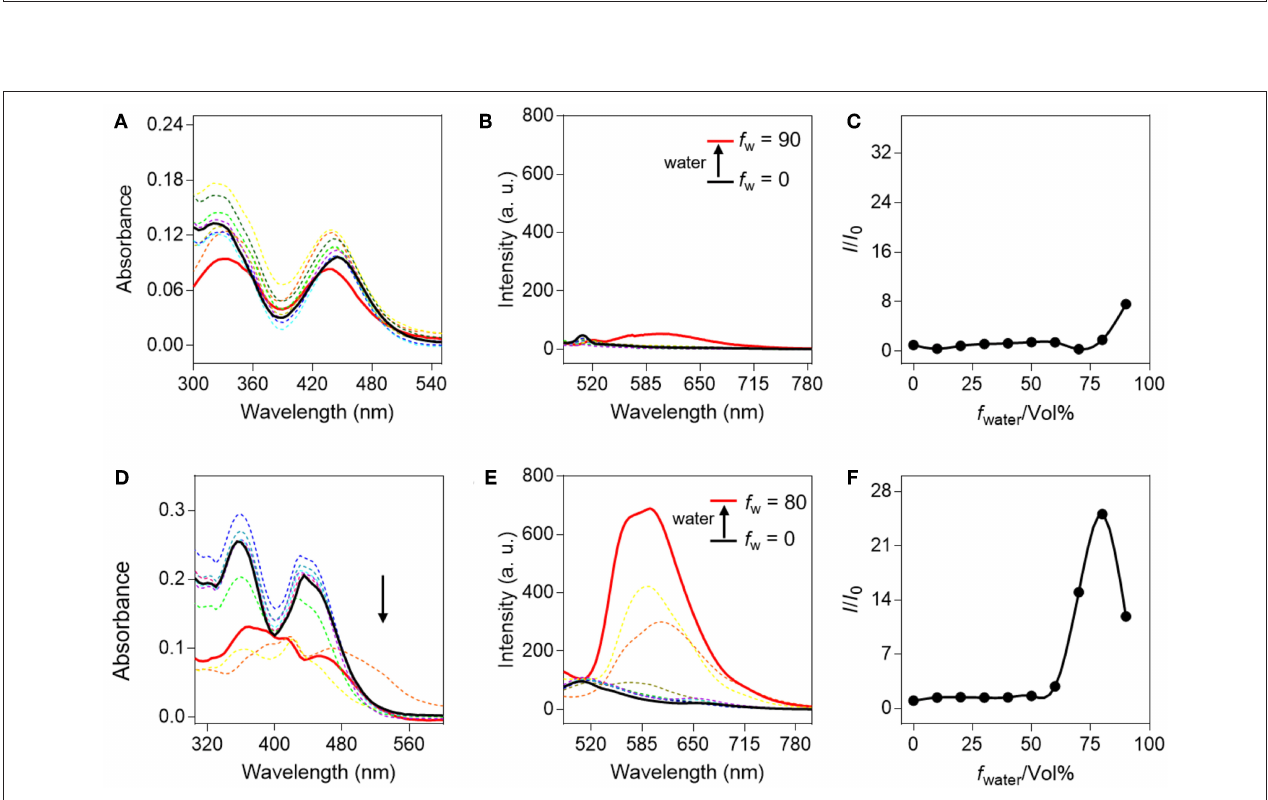
Frontiers in Chemistry | www.frontiersin.org